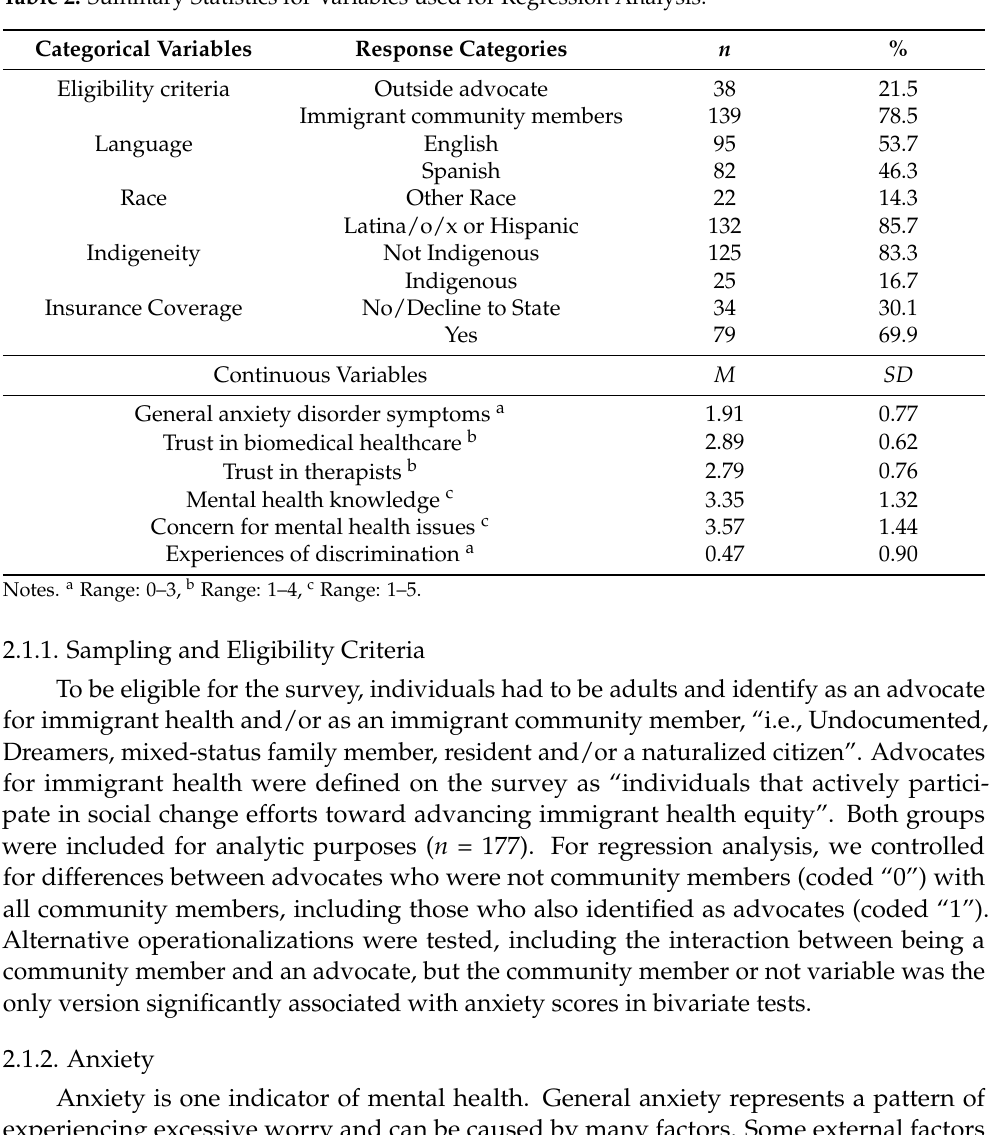
Table 2. Summary Statistics for Variables used for Regression